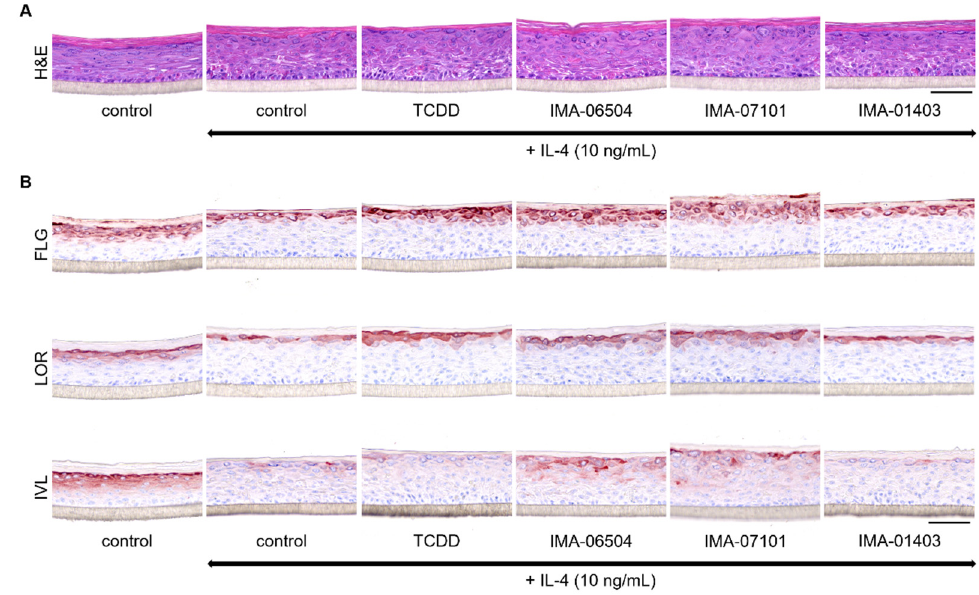
Figure 5. Therapeutic effect of TASQ derivatives in the AD-HEE model. ( A ) H&E staining of HEEs stimulated with 10 ng/mL IL-4 for 24 h followed by co-stimulation with the compounds for another 72 h. ( B ) Analysis of epidermal differentiation proteins via immunostainings for filaggrin ( FLG ), loricrin ( LOR ) and involucrin ( IVL ). Scale bar = 100 µm.